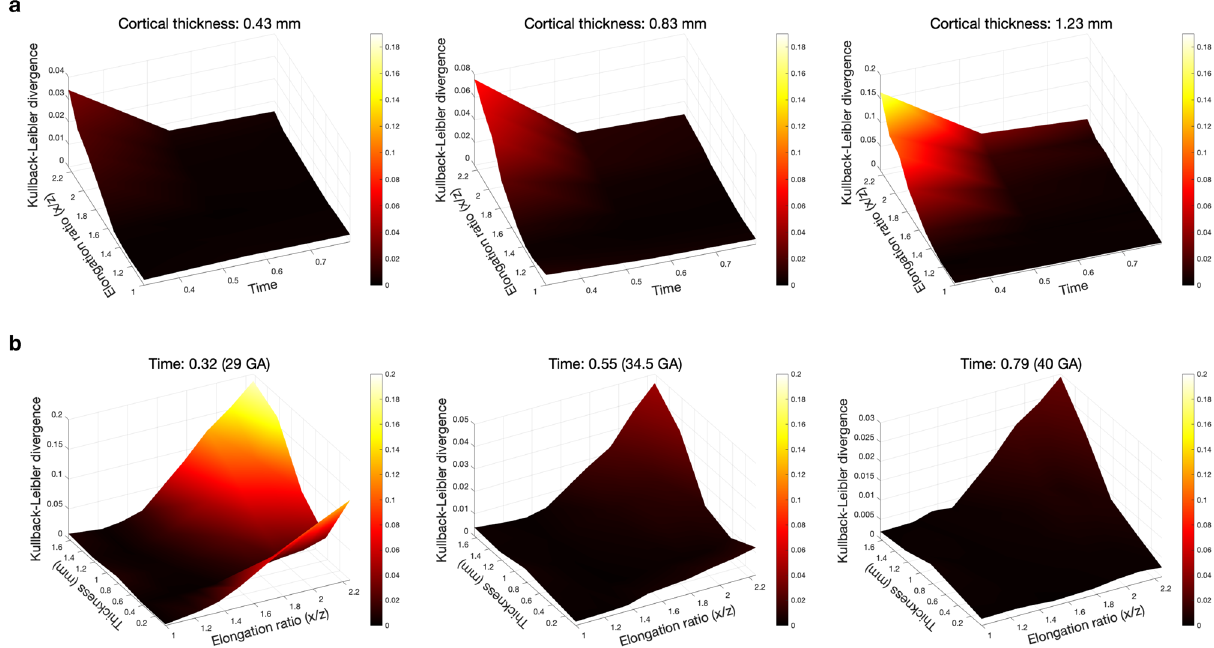
Figure 9. Kullback–Leibler divergence of uniformity of angular distribution for geometries with different elongation ratios and initial cortical thicknesses. Two scales are used here: the z-axis varies in each frame to allow a clear visualization of the behavior of KL divergence for a fixed initial cortical thickness ( a )/time of model ( b ); the colorbar is the same across a row to show the evolution of KL divergence relative to uniform